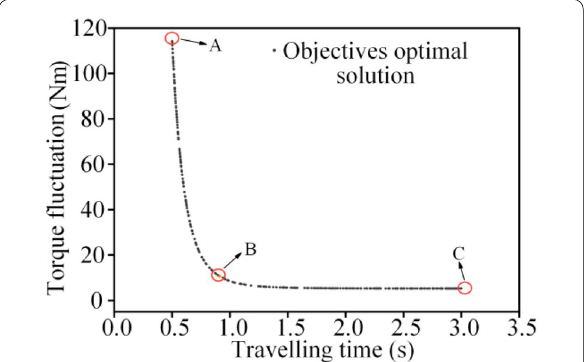
Figure 7 Approximate true Pareto front for trajectory planning